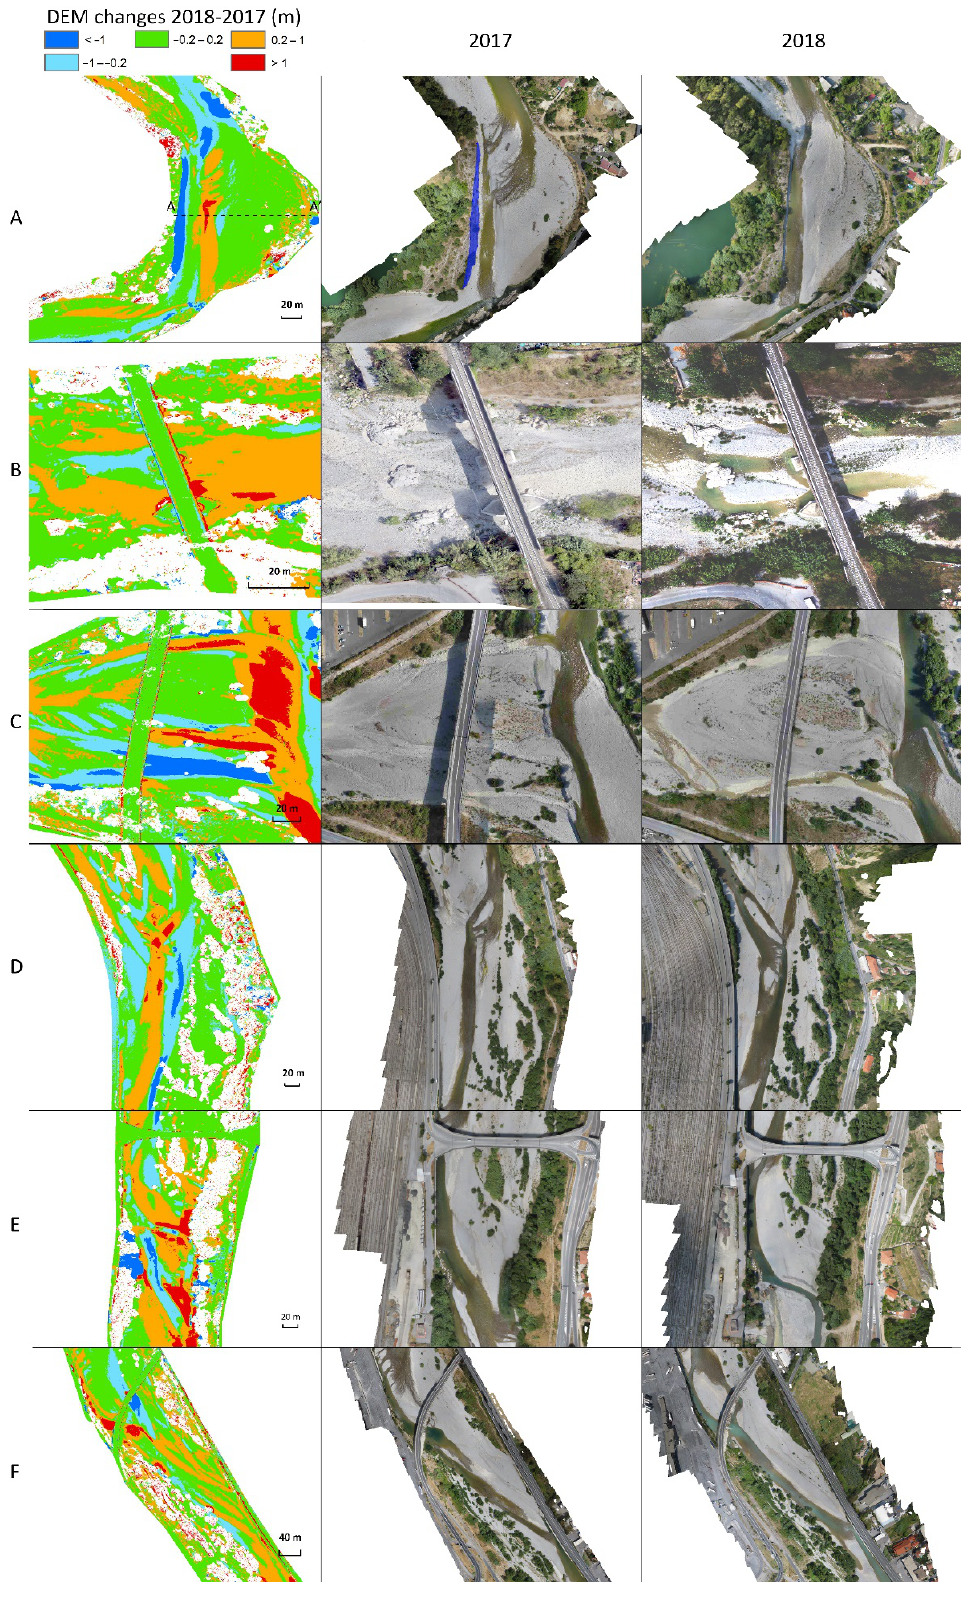
Figure 9. Some details of the differences between DTMs. Letters A−F specify the area and refer to Figure 8. The second and the third columns show the 2017 and 2018 orthophotos, respectively. The blue polygon in the 2017 orthophoto highlights the retreat of the riverbank of about 4 m.